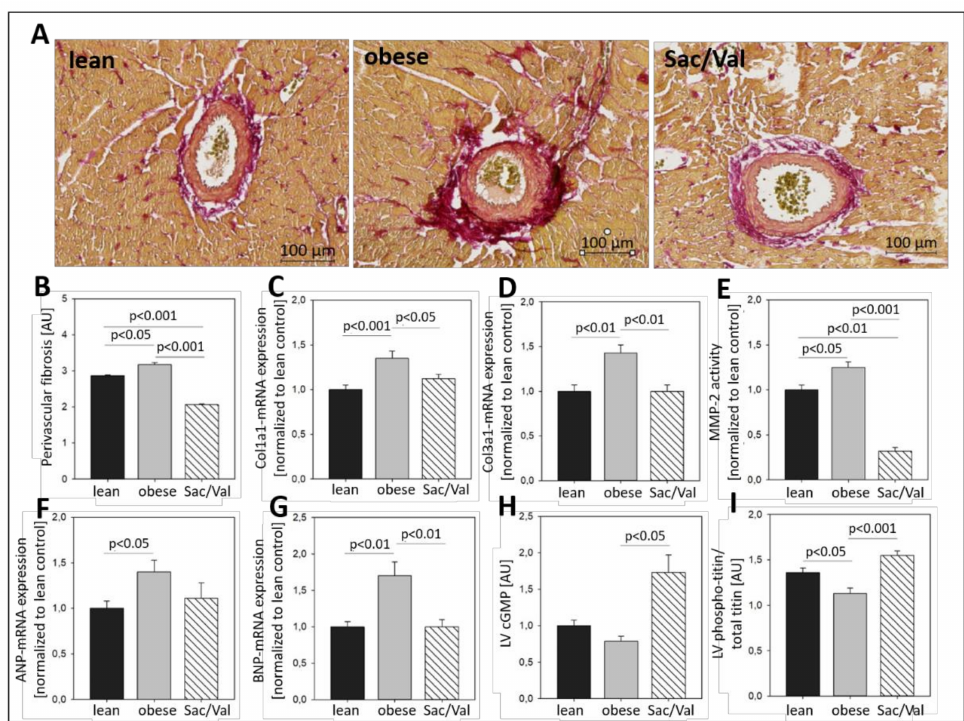
Figure 5. LV fibrosis and remodeling after 12 weeks of Sac/Val treatment. Brightfield microscopy of perivascular fibrosis in representative picrosirius-stained heart sections ( A ). Quantification of LV perivascular fibrosis ( B ). LV mRNA expression of Col1a1 ( C ) and Col3a1 ( D ). MMP-2 activity measured in LV tissue ( E ). LV mRNA expression of ANP ( F ) and BNP ( G ). cGMP concentration measured in LV tissue ( H ). LV protein expression of phosphorylated titin ( I ). n = 13–14. To test the effect of Sac/Val one-way analysis of variance (ANOVA) followed by Bonferroni post hoc was used to compare